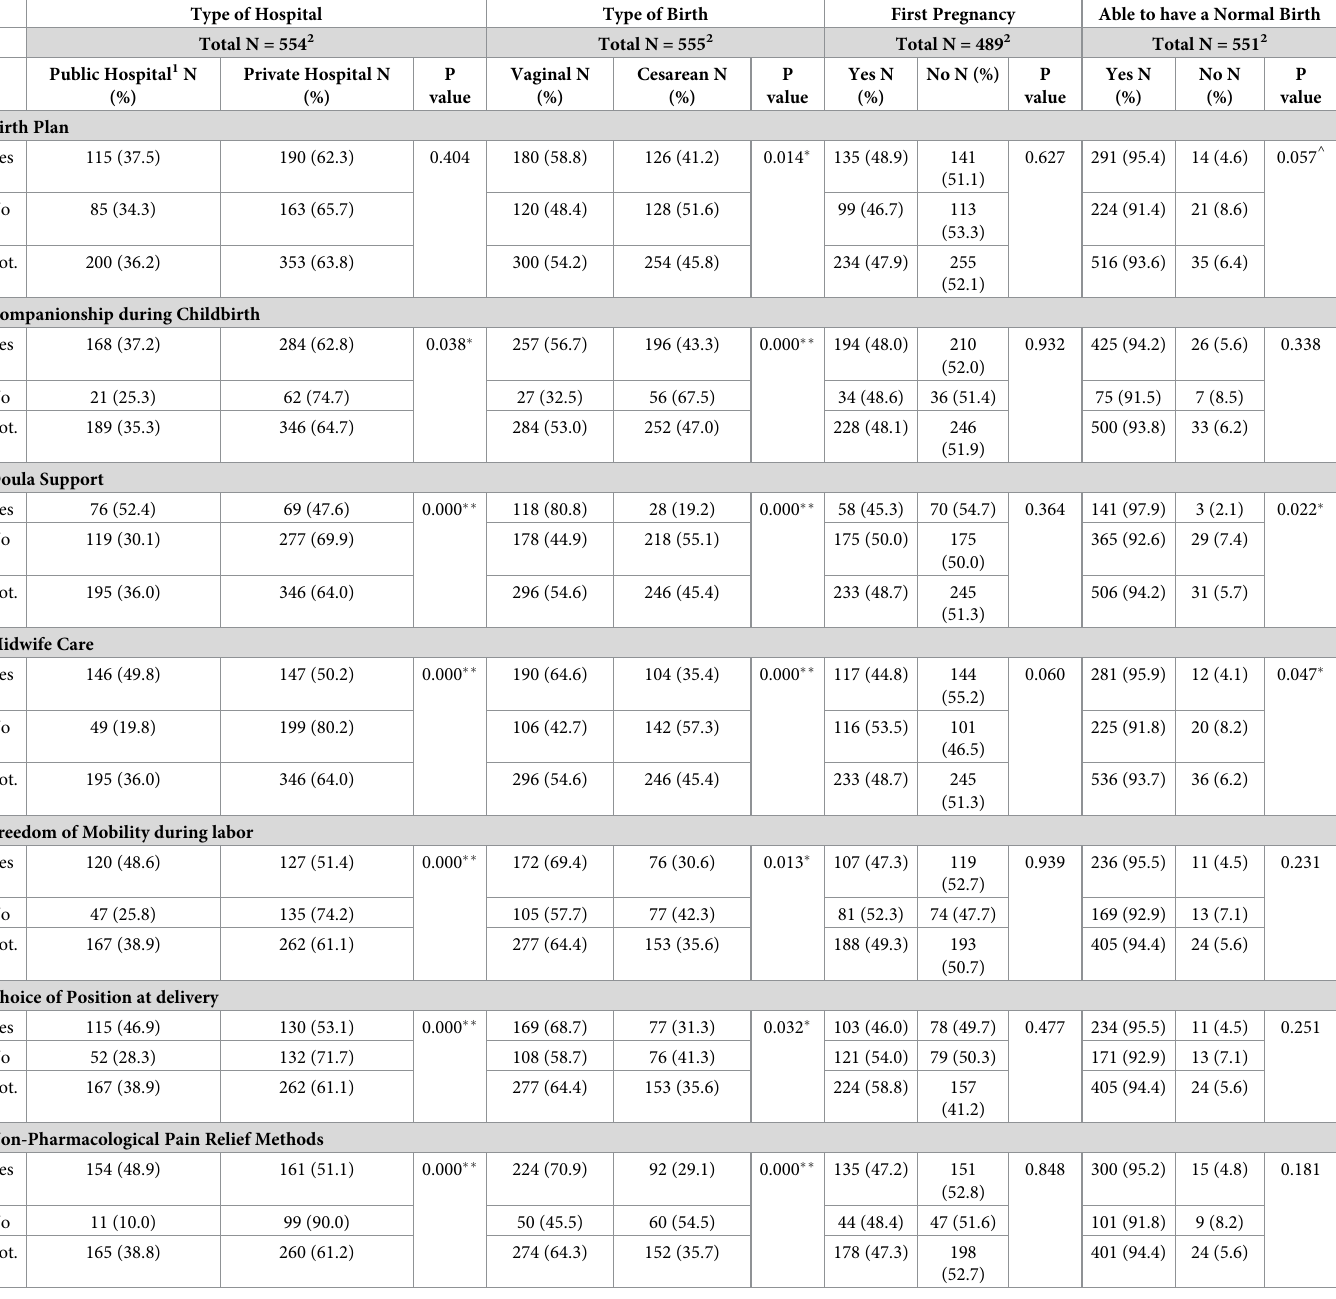
Table 3. Use of intrapartum evidence-based practices among women in the Senses of Birth intervention who participated in the follow-up survey, by type of hospi- tal, type of birth, and parity. Brazil, 2015–2016. Type of